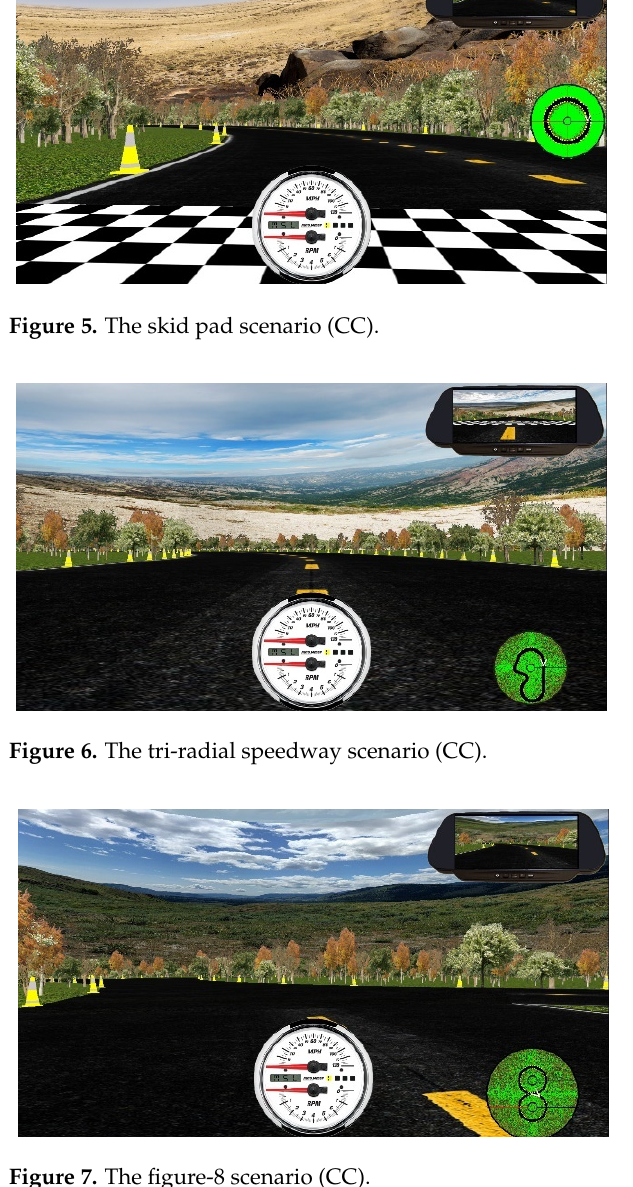
Figure 8. Residential driving scenario.